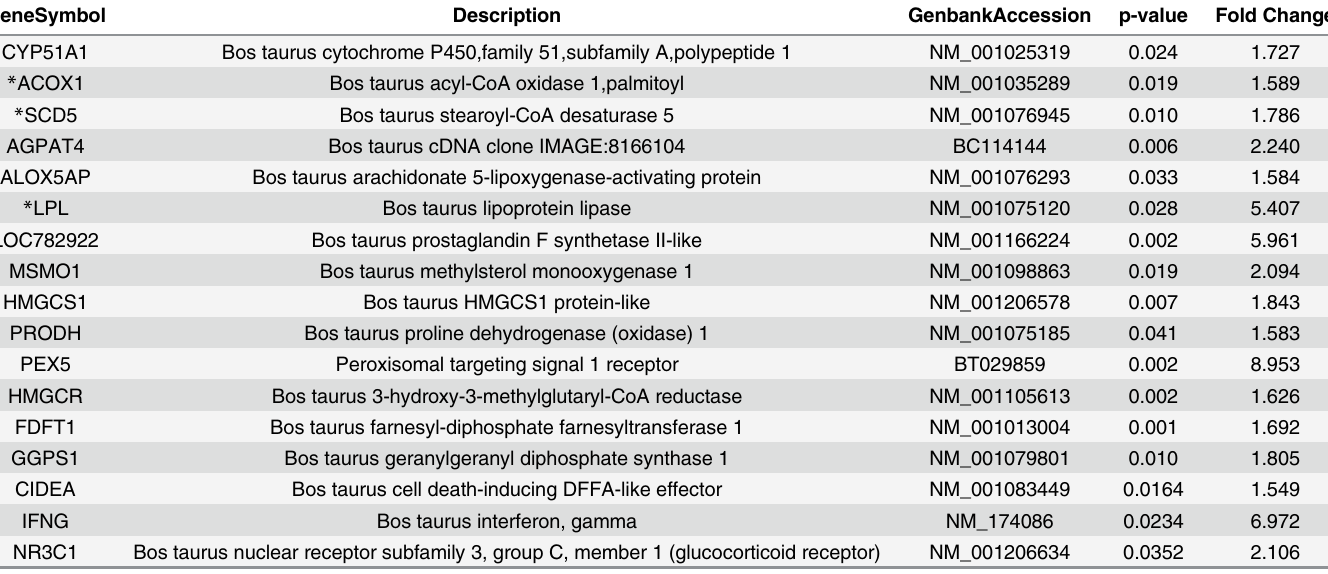
Table 2. The significantly up-regulated lipid metabolism-related genes in fat-1 transgenic cattle.